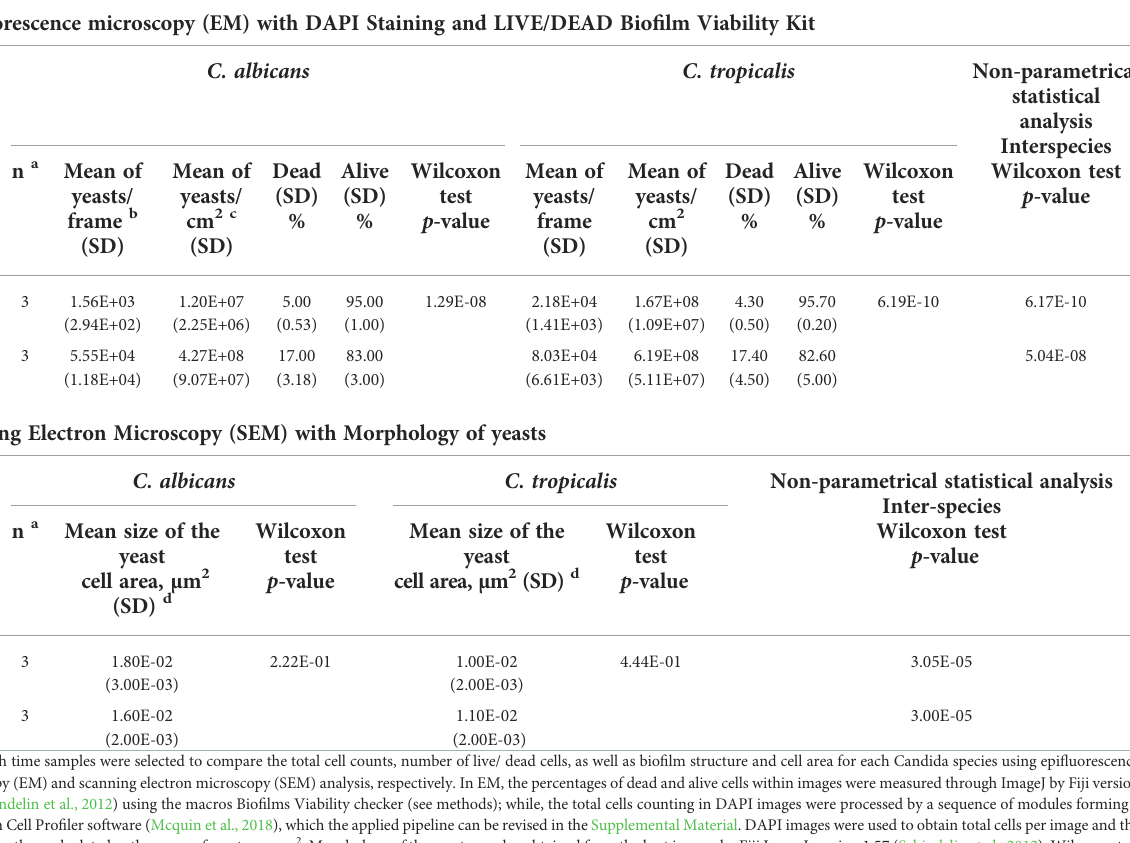
TABLE 3 Evaluation of the total cell counts, live/dead cells and cell morphologies between bio fi lms of Candida albicans and Candida tropicalis at 48 and 72h.